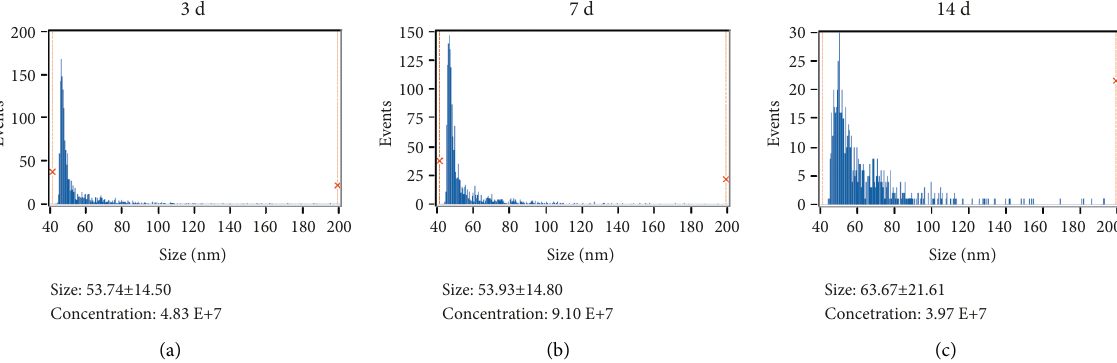
Figure 2: Concentration and size of the exosomes isolated from culture medium of rat lenses were measured using nFCM. (a) Exosomes isolated from the pooled medium of ten rat lenses at day 3. (b) Exosomes isolated from the pooled medium of ten rat lenses at day 7. (c) Exosomes isolated from the pooled medium of ten rat lenses at day